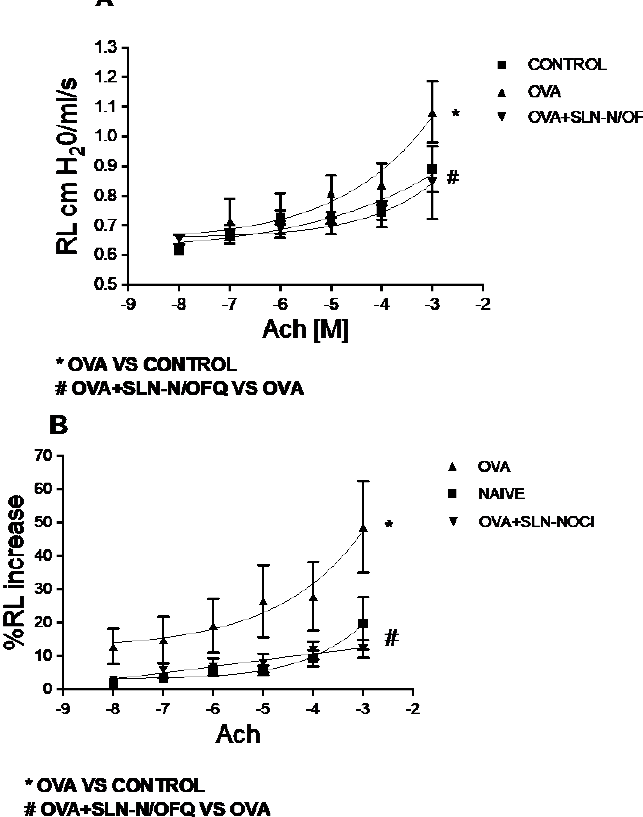
Figure 5. Absolute ( A ) and percentage ( B ) expression of lung resistances (RL) on ACh-induced bronchoconstriction. Endotracheal pretreatment of N/OFQ-SLNs causes a significant reduction in ACh-induced bronchoconstriction with respect to vehicle-treated rats ( A , B ). Data are means ± SEM (n = 10). * p < 0.05.